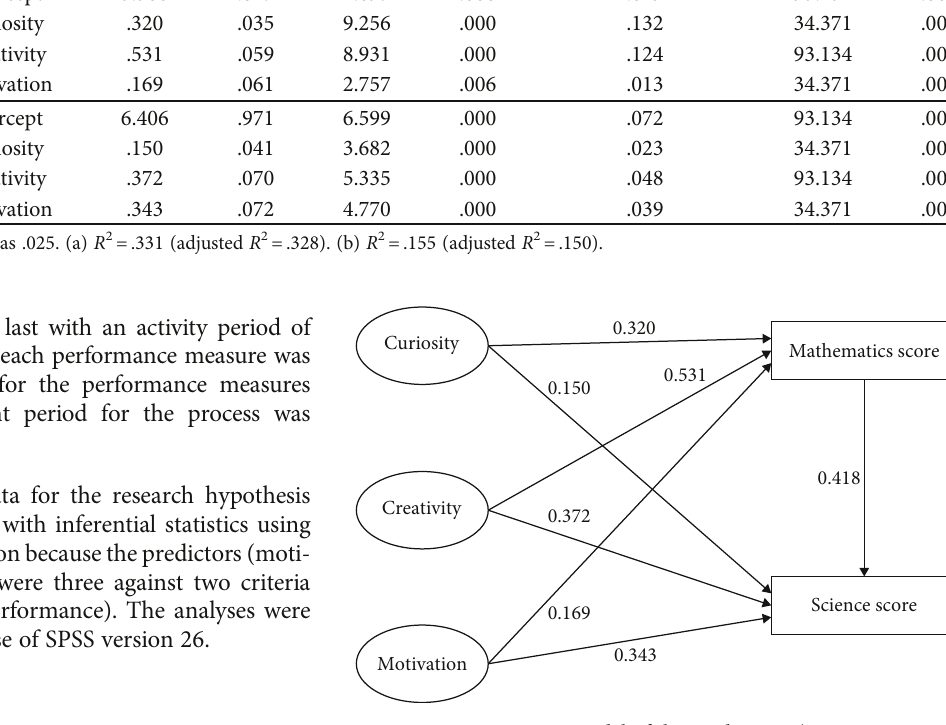
F IGURE 1: Parsimonious model of the predictions (motivation, crea- tivity, curiosity, science score, and mathematics